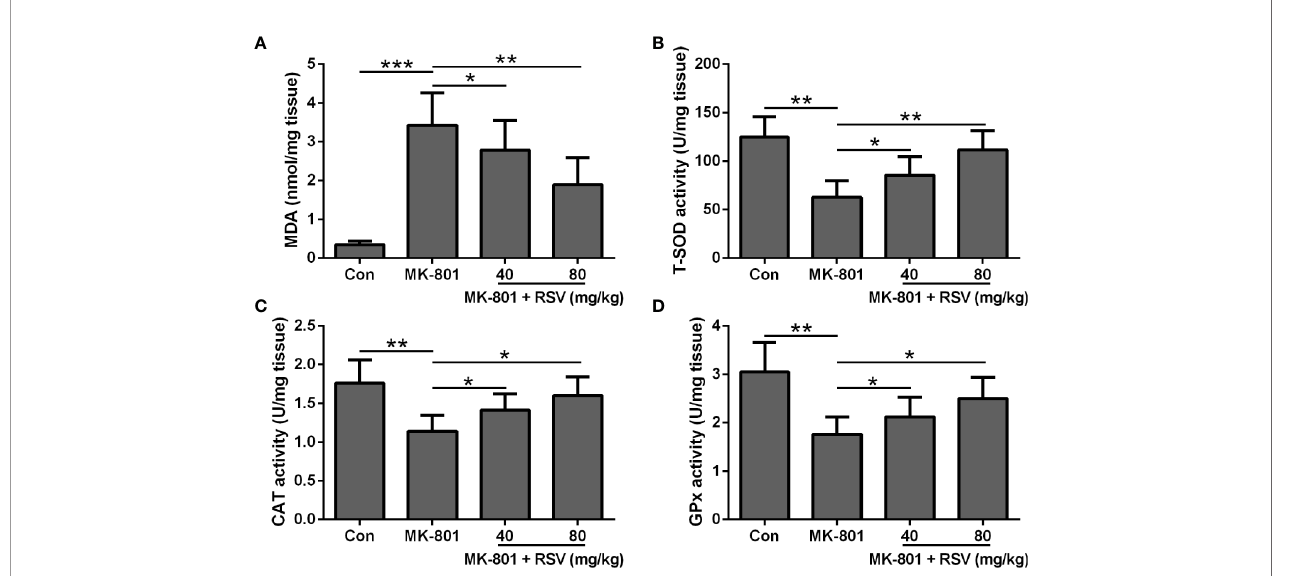
FIGURE 3 | Effect of RSV on the levels of oxidative stress in the hippocampus of MK-801 treated rats. MDA levels (A) , T-SOD activity (B) , CAT activity (C) , and GPx activity (D) were detected in the hippocampus. n = 6 in each group. Data were presented as mean ± SD. F ratios: (A) 31.98 (3.00, 20.77), (B) 16.36 (3.00, 17.38), (C) 9.818 (3.00, 21.12), (D) 11.39 (3.00, 13.45). *p < 0.05, **p < 0.01, and ***p < 0.001 between the indicated